Question: What caption would you write for this figure?
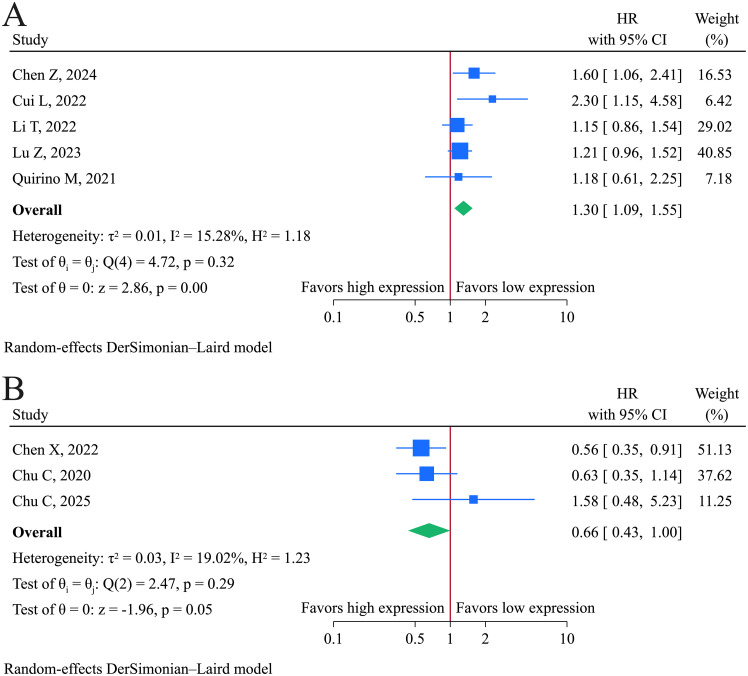
Answer: Forest plot of the association between tumoral Siglec-15 expression and DFS/RFS (A) and DSS (B) in solid tumors. DFS, disease-free survival; DSS, disease-specific survival; HR, hazard ratio; RFS, relapse-free survival.